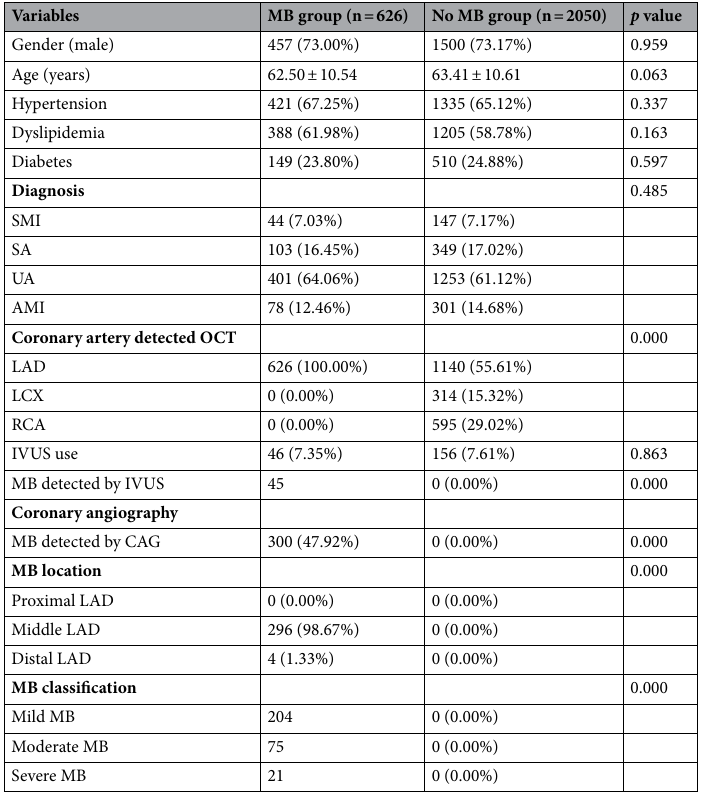
Table 3. Basic clinical characteristics between MB and non-MB groups detected by optical coherence tomography. Data were expressed as n (%), mean ± SD. Variance analysis, P1; SMI silent myocardial ischemia, SA stable angina, UA unstable angina, AMI acute myocardial infarction, LAD left anterior descending coronary artery, LCX left circumflex coronary artery, RCA right coronary artery, CAG coronary